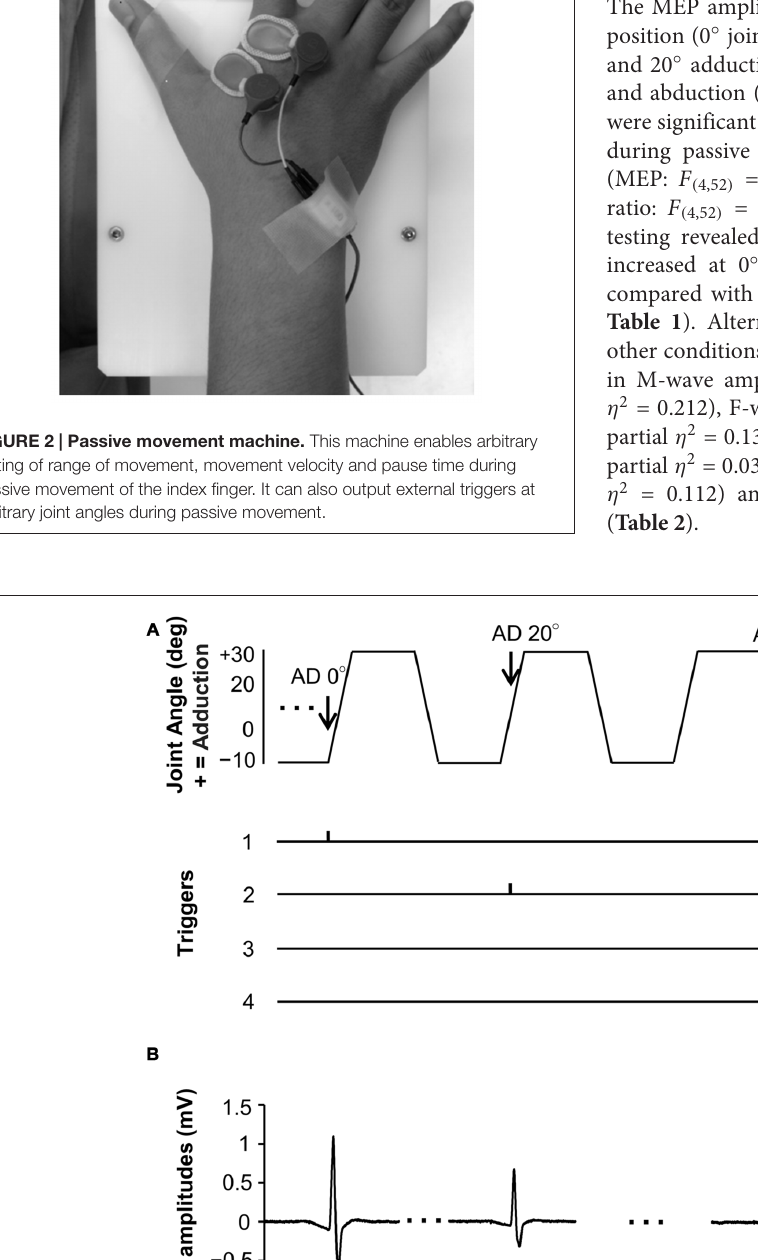
Frontiers in Human Neuroscience |